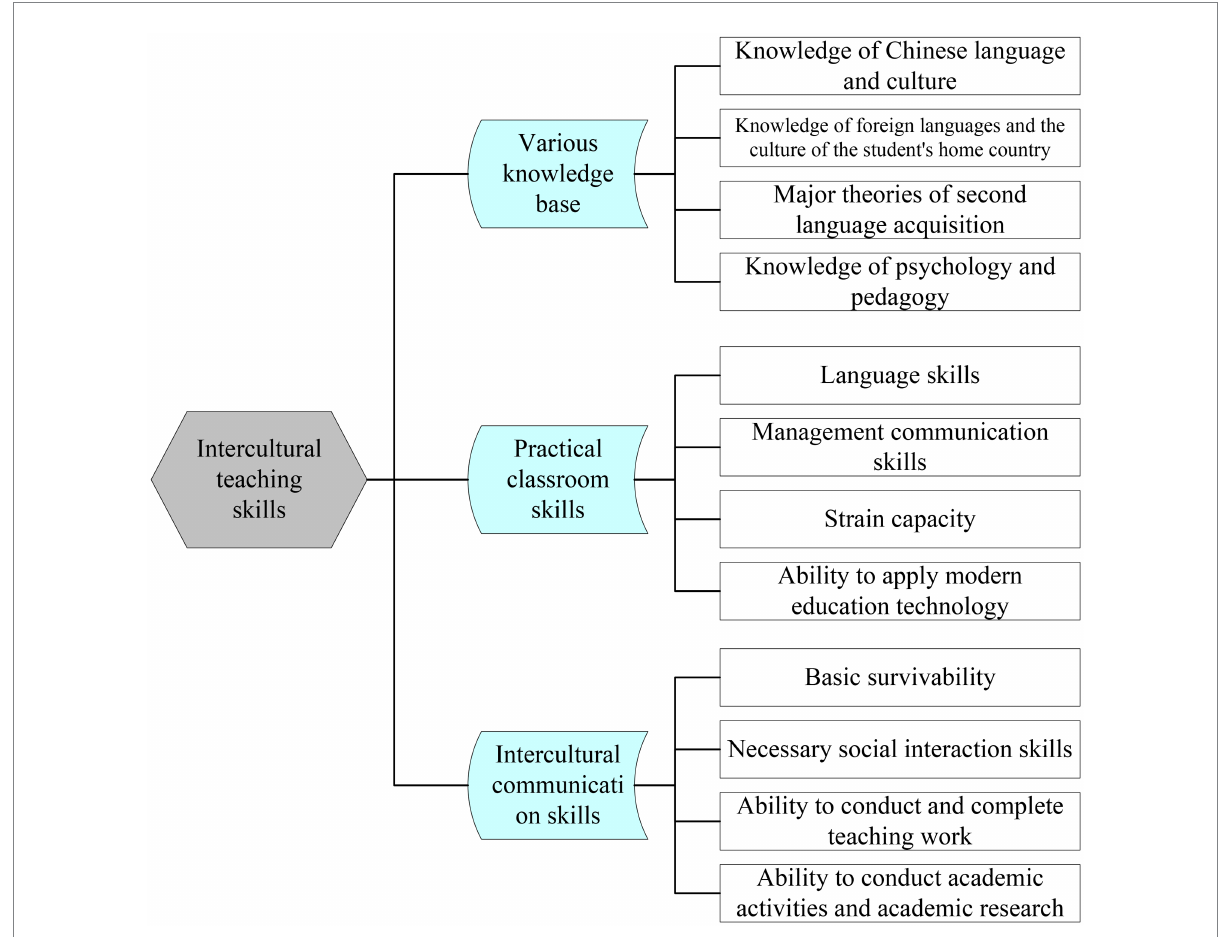
FIGURE 2 Composition of cross-cultural teaching competence in